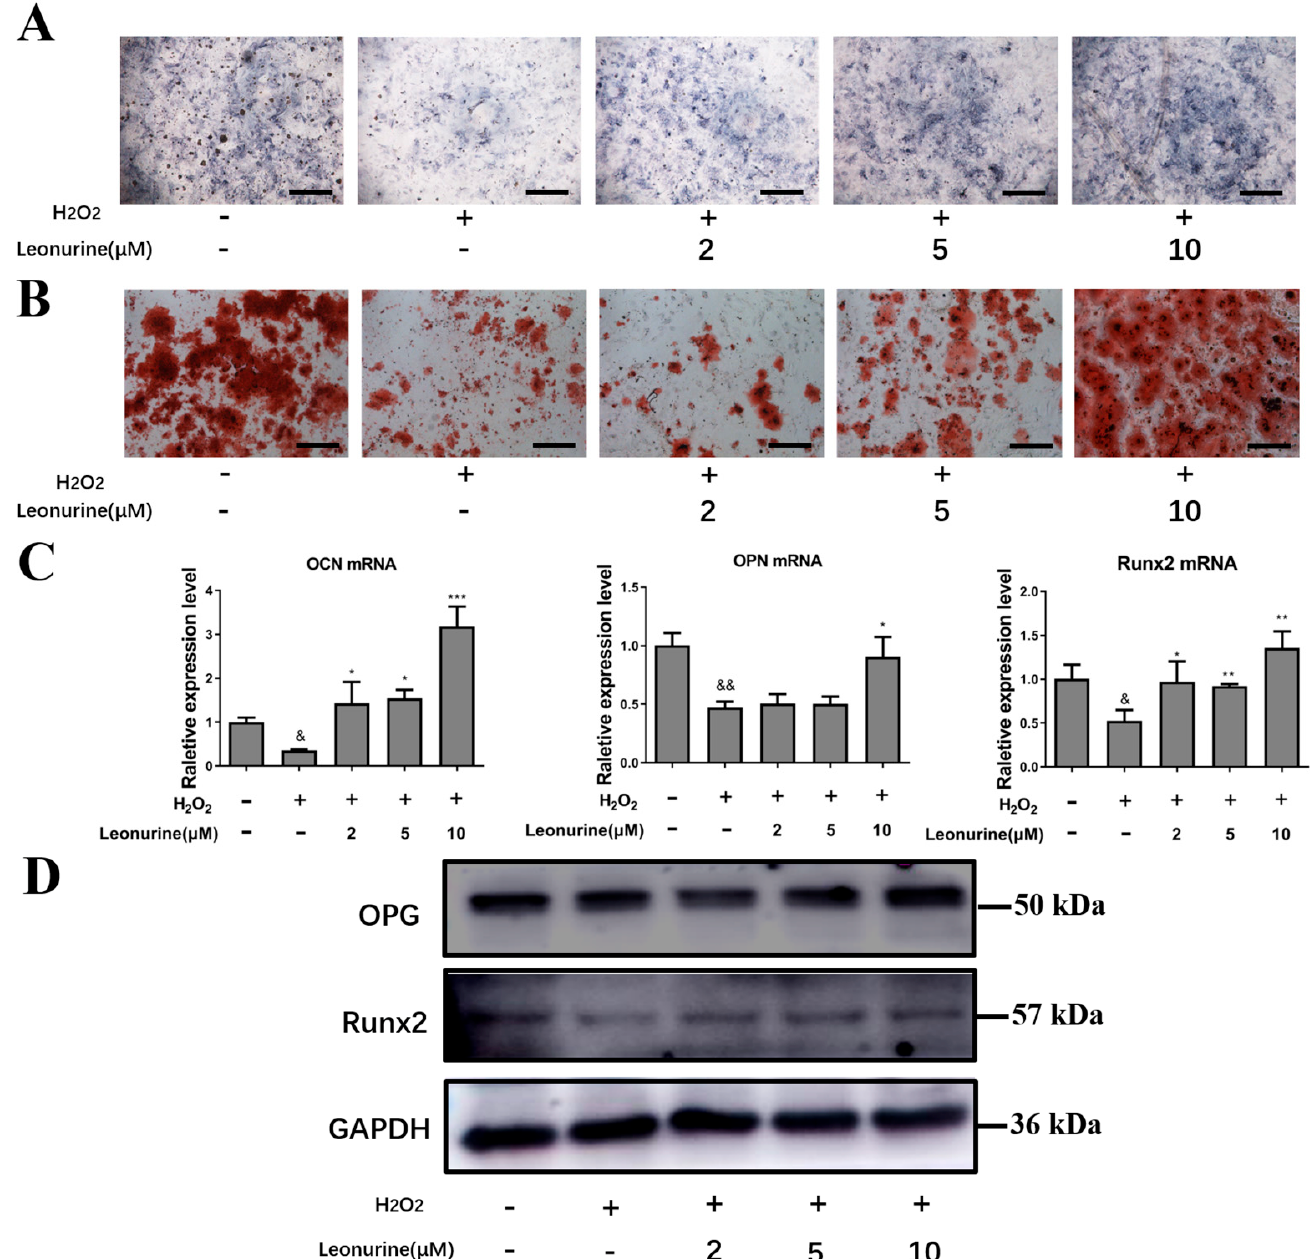
Figure 1. ( A ) CCK-8 essay for BMSCs co-cultured with different concentrations of H 2 O 2 . ( B ) Evalu- ation of leonurine protection at different concentrations in skeptical ROS burden. ( C ) Double live/dead staining (scale bar = 200 μ M). ( D ) Distribution of apoptotic BMSCs observed under flow cytometry (FITC-Annexin V apoptotic detection assay). ( E ) Expression of apoptosis-related protein marker. Leonurine can help BMSCs survive from an overload ROS environment. (&& p < 0.01 vs.